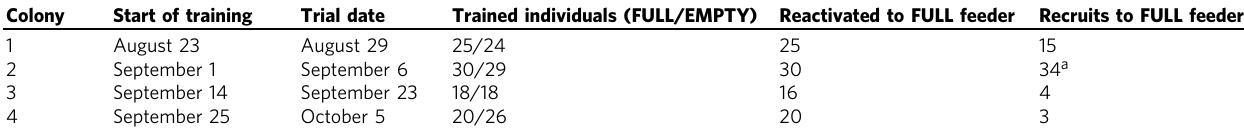
Table 1 Overview of experimental trials.